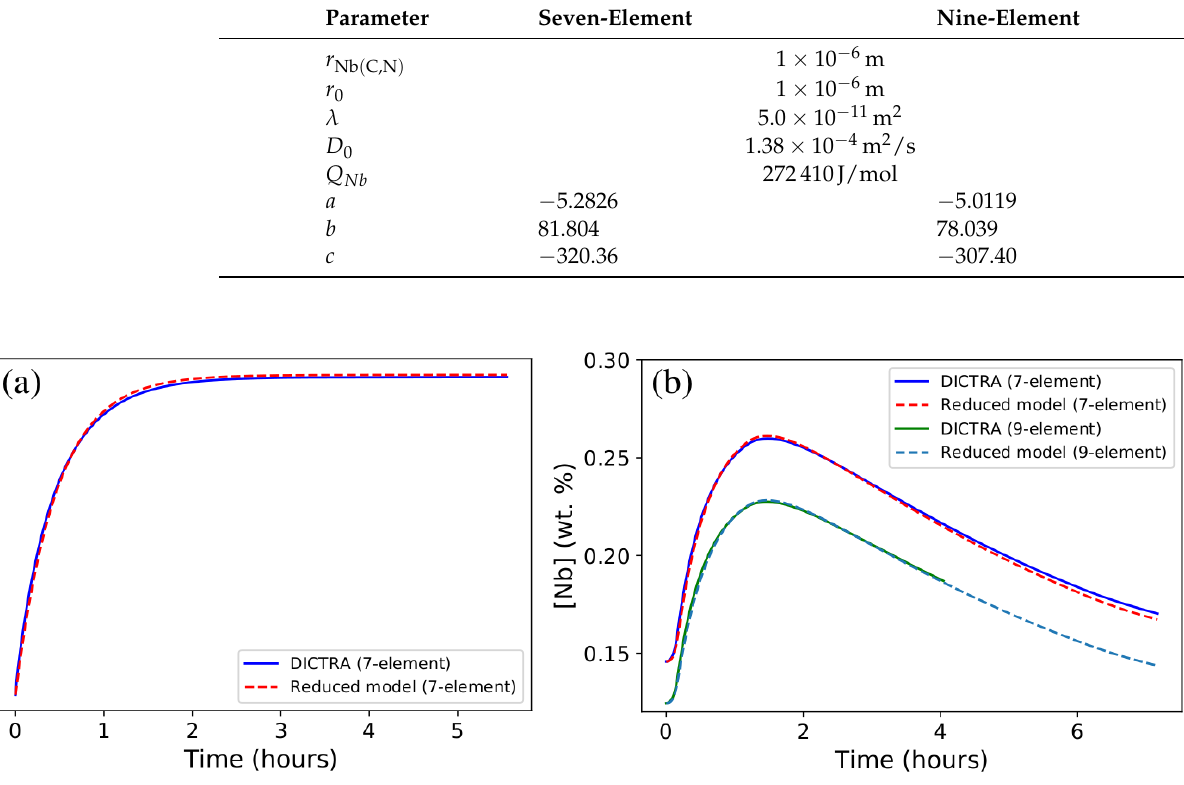
Figure 6. Comparison of mean Nb content in austenite, [Nb], calculated using DICTRA, and that obtained from the reduced model (Equation (1)) for ( a ) isothermal holding at 1473 K with the characteristic time τ = 1638 s (seven-element calculation using TCFE9) and ( b ) the anisothermal 1473–1373 cycle (7- and 9-element calculations using